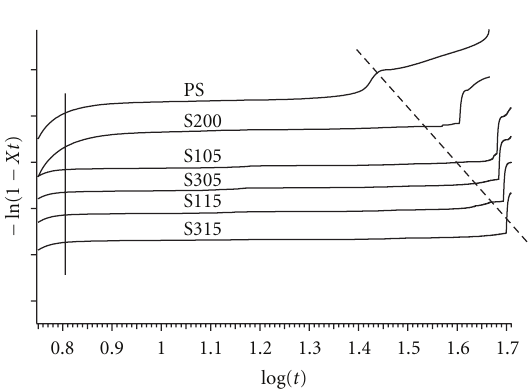
Figure 8: Decay of overall crystallinity based on the nonisothermal crystallization kinetics analysis using the modified Avrami equa- tion. Plots are shown for key samples. All plots were corrected for the baseline and o ff set for clarity.